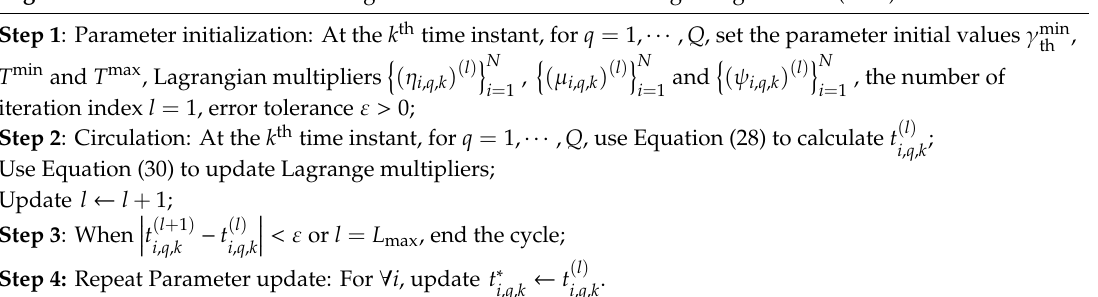
Algorithm 1 Dwell time allocation algorithm based on the Nash bargaining solution (NBS)